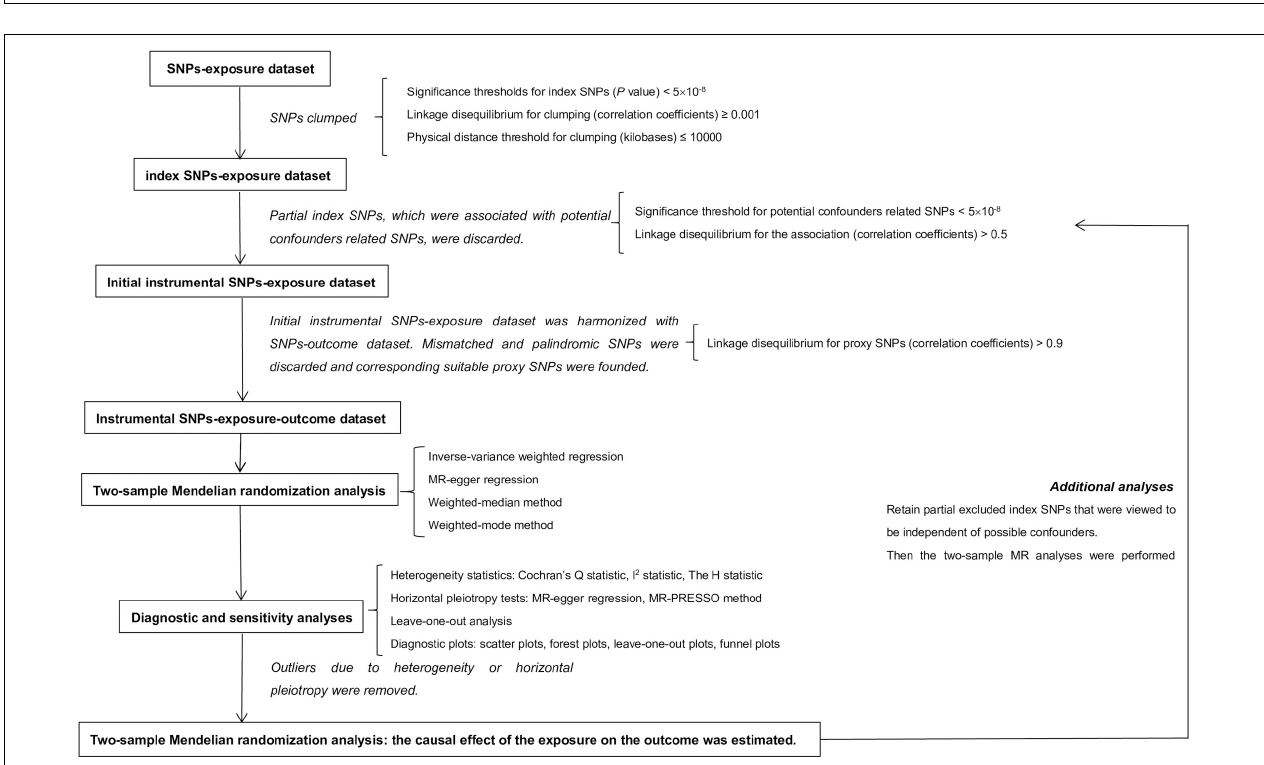
FIGURE 2 | Study design of two-sample Mendelian randomization analysis. In this MR analysis, exposure and outcome refer to body shape and Alzheimer’s disease separately. MR, Mendelian randomization.